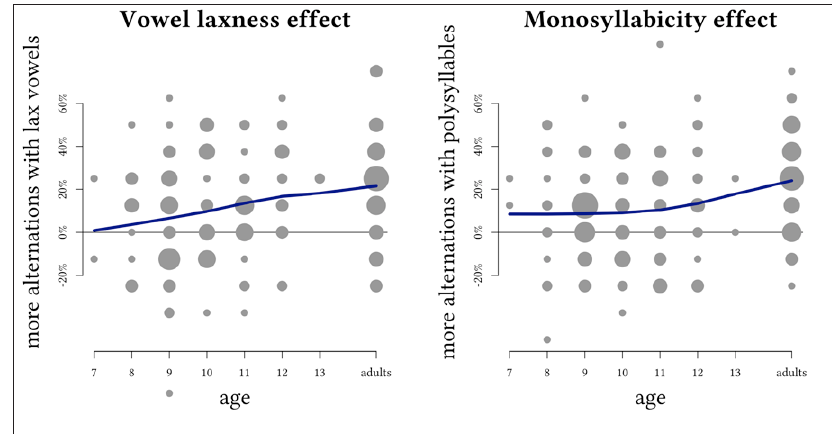
Figure 3: Experimental results by participant ( n =